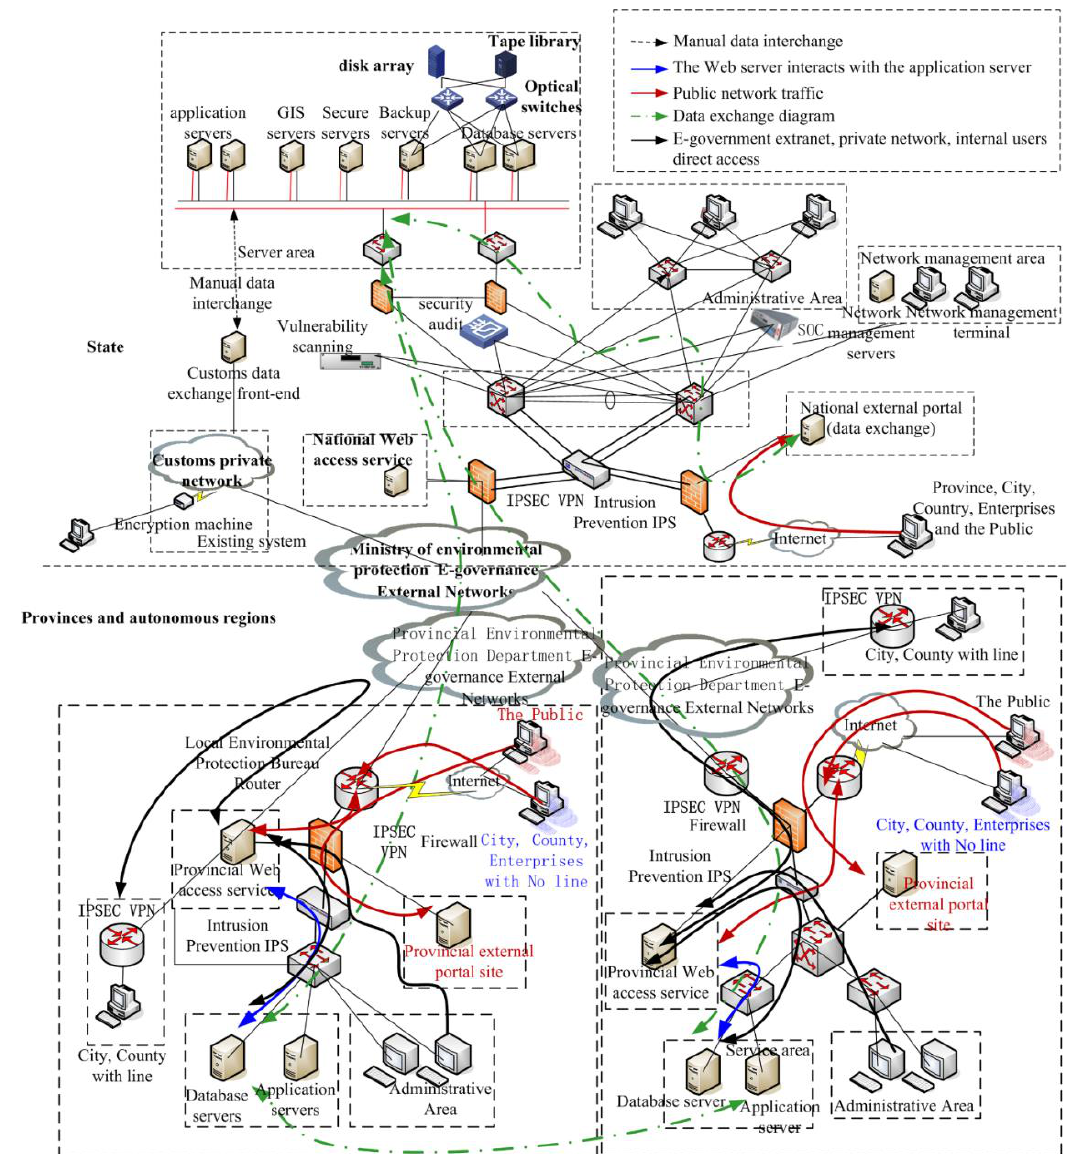
Figure 3. Diagram of electronic waste information management network [65].